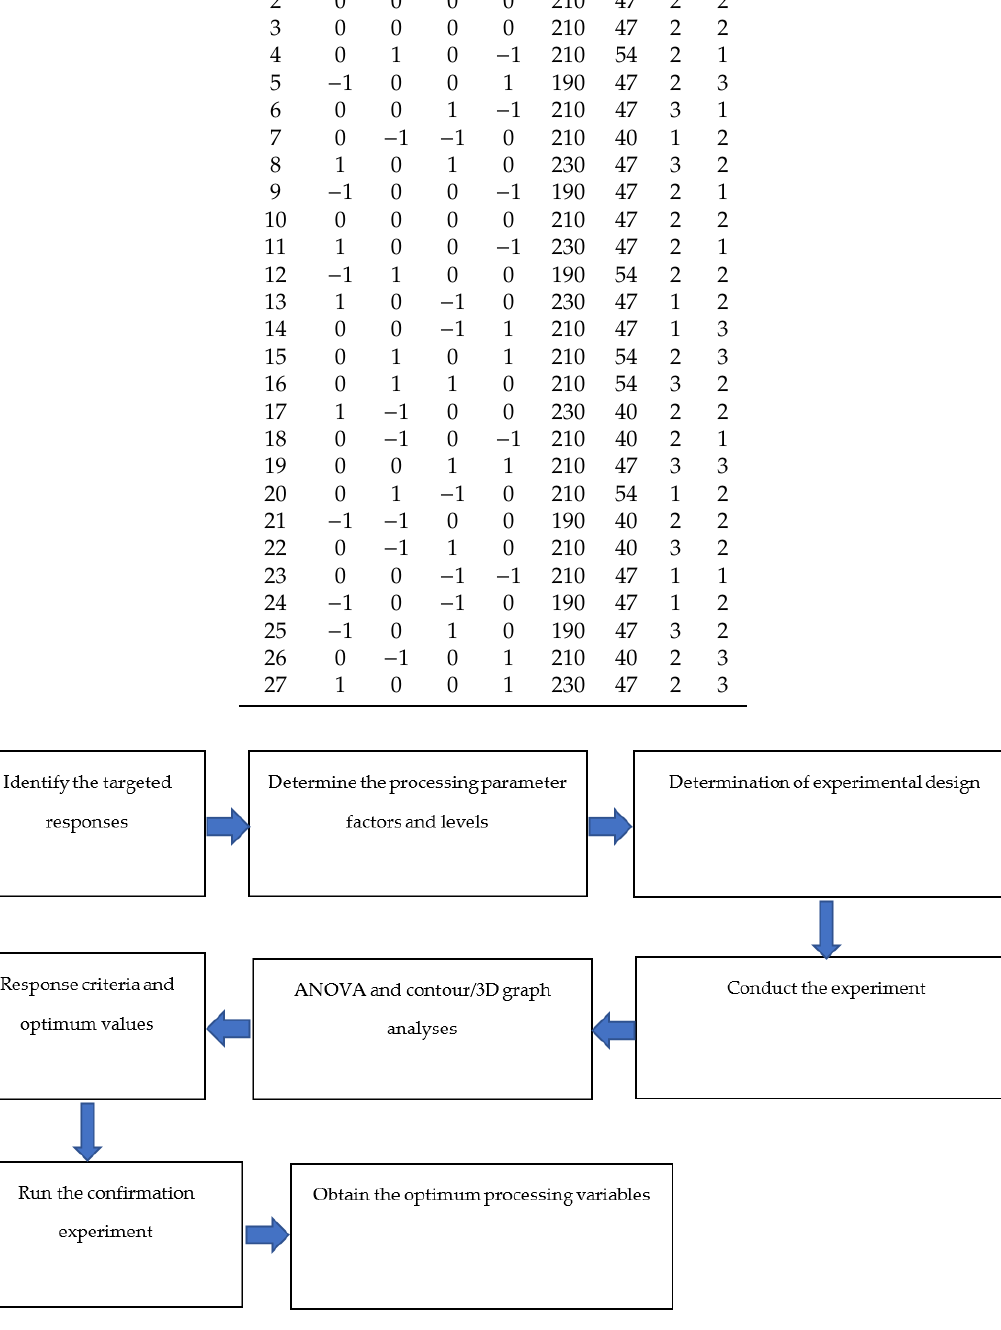
Figure 5. Experimental sequence. Table 3. Three-level four-factor experimental design.